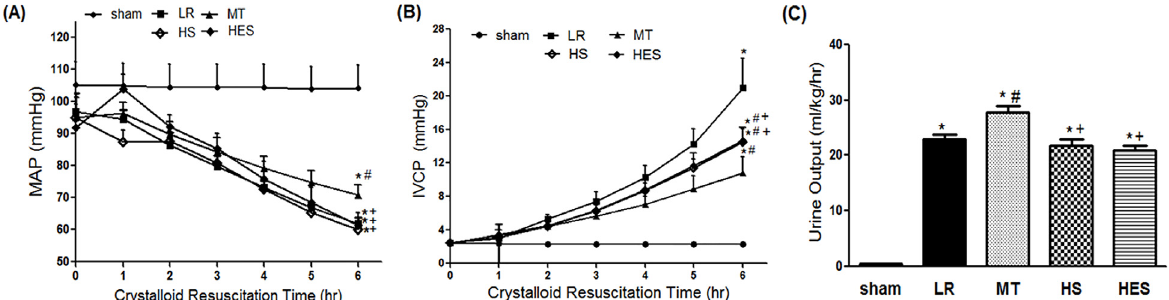
Fig 4. Changes in the mean arterial pressure (MAP) and inferior vena cava pressure (IVCP) during the crystalloid resuscitation time and comparisons of urine output between groups. (A) Changes in the MAP of groups during the crystalloid resuscitation time. (B) Changes in the IVCP of groups during the crystalloid resuscitation time. (C) Comparison of urine output during the crystalloid resuscitation time. Data are presented as means ± S.E.M., n = 8 in each group. * P < 0.05 in comparison with the sham group, # P < 0.05 in comparison with the LR group, + P < 0.05 in comparison with the MT group.